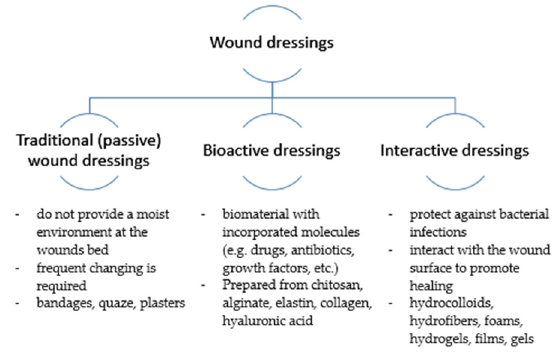
Figure 3. Classification of the currently used wound dressings.